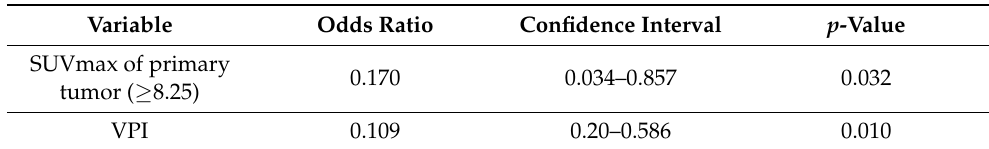
Table 5. Multivariate analysis for factors associated with false negatives in integrated 18F-FDG- PET/CT negative patients.